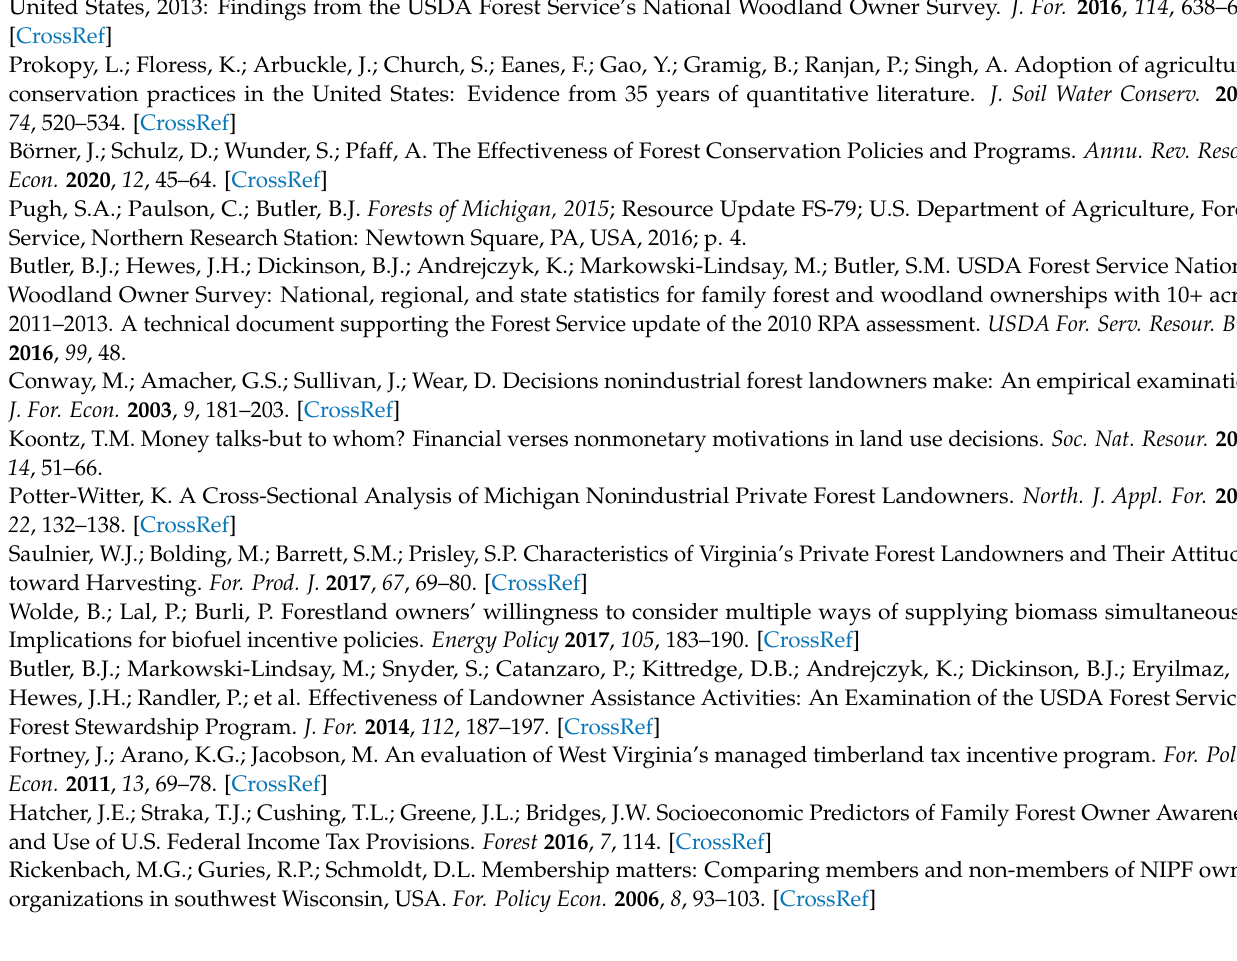
Table S11: Multinomial logistic regression parameter estimates for significant results. Stand condition as independent variable. Southern Lower Peninsula. N = 20,915 unique forest stands enrolled in the Qualified Forest Program. Table S12: Multinomial logistic regression parameter estimates for significant results. Stand condition as independent variable. Western Upper Peninsula. N = 20,915 unique forest stands enrolled in the Qualified Forest